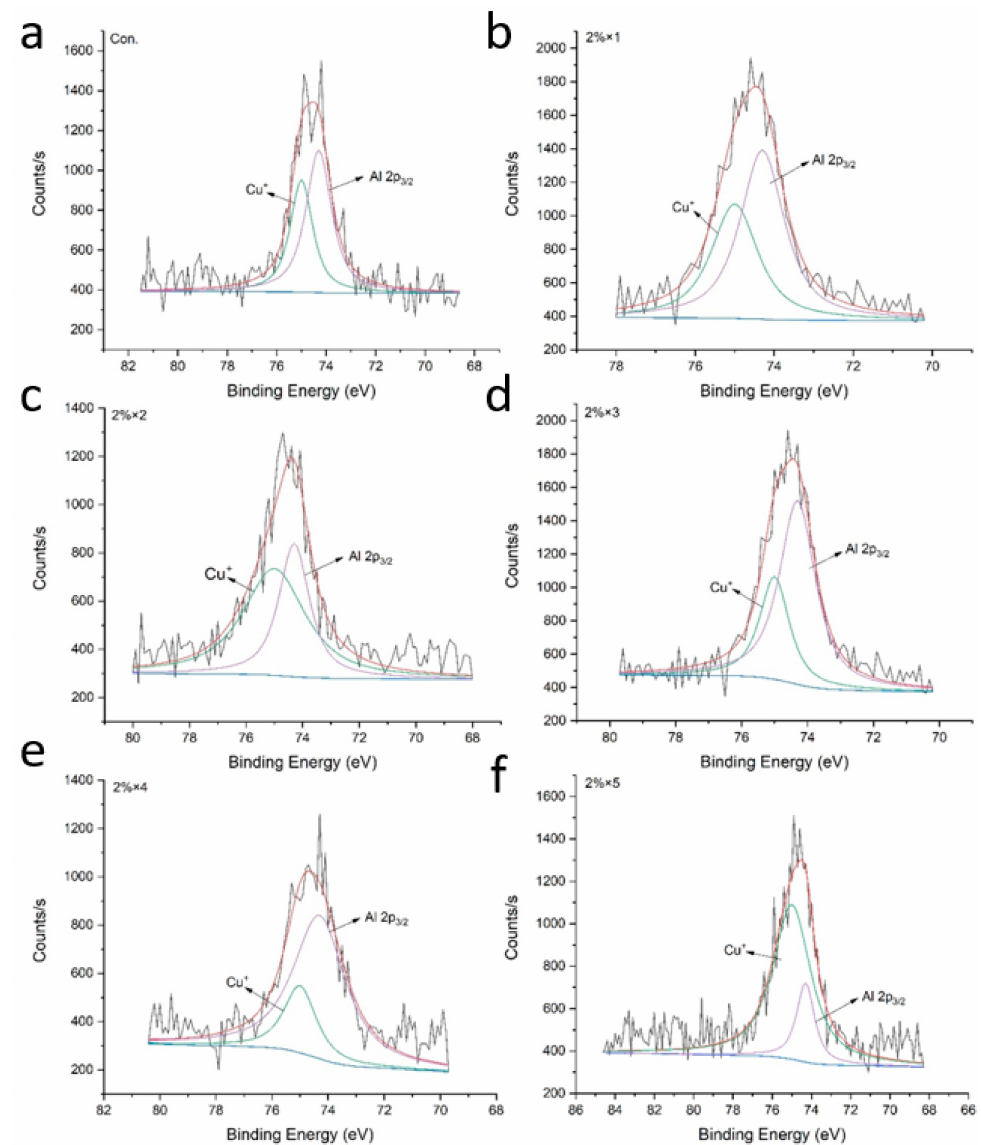
Figure 13. The XPS spectra of Cu 3p from the surface of SASs (Con.) ( a ), and application of 2% BR for one season (2% × 1) ( b ), two seasons (2% × 2) ( c ), three seasons (2% × 3) ( d ), four seasons (2% × 4) ( e ), five seasons (2% × 5) ( f